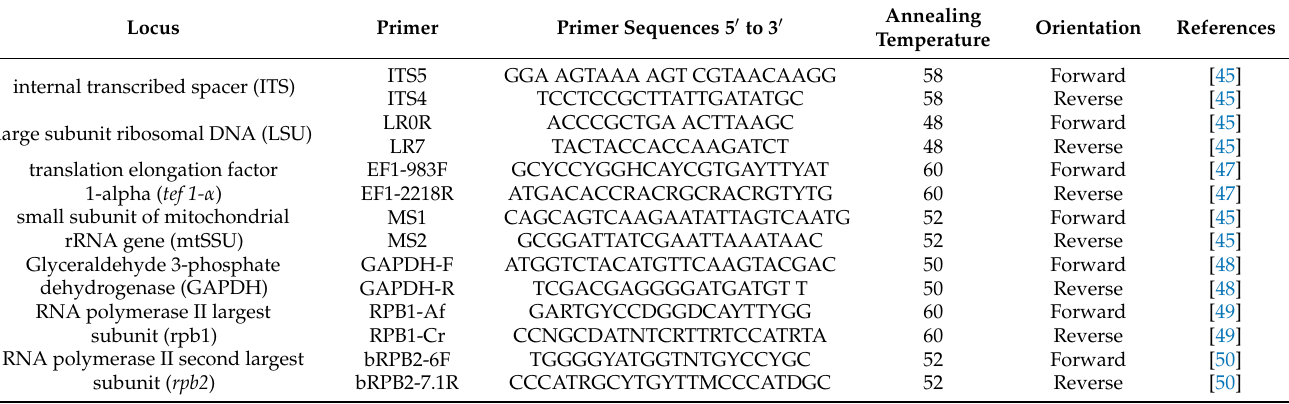
Table 1. Primers used in this study, with sequences and references.